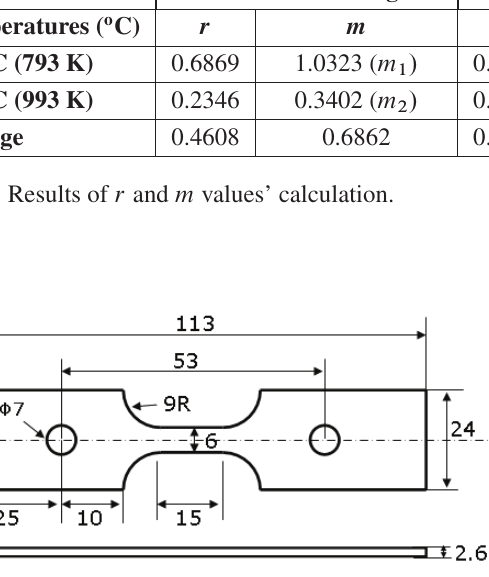
Figure 1. Shape of specimen for uni-axial tensile test at elevated temperatures.